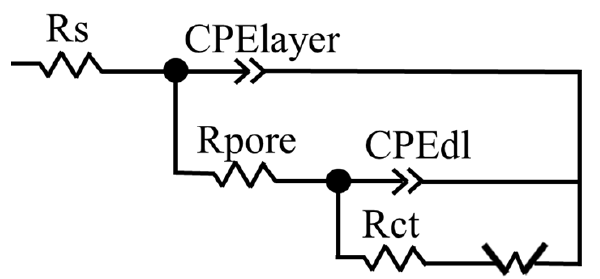
Figure 6. Equivalent circuit used for fitting.